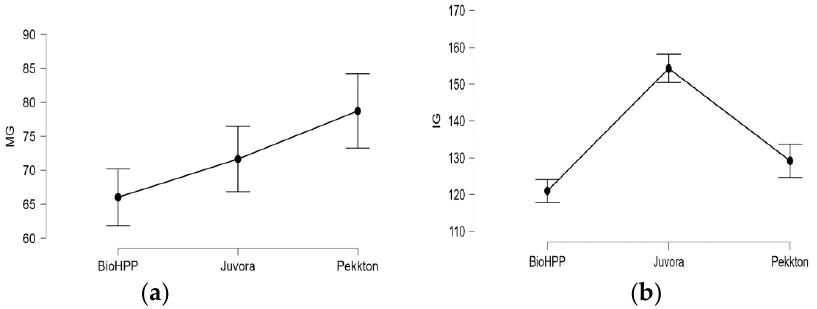
Figure 8. Descriptive plots of ( a ) MG and ( b ) IG for all materials. Table 4. p values regarding MG and IG among polymer groups ( n = 8).